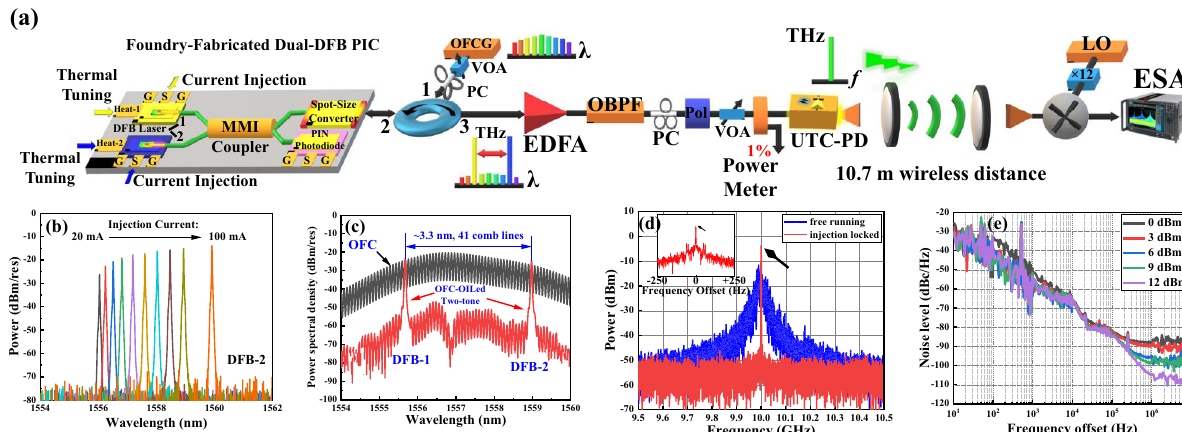
Fig. 3 Experimental setup and results of high-purity THz carriers generation. a A master-slave optical injection-locking-based THz carrier generation scheme. The two DFB lasers are injection-locked as slaves by the master OFCG. The polarization state and injection strength are controlled and optimized by a polzarization controller (PC) and a variable optical attenuator (VOA), respectively. The output OFCG-locked two-tone signal passes through the port 3 of the circulator. The wavelength of each DFB tone is tuned by the thermal tuning current of the integrated heater, and the intensity is controlled with the injection current. The two-tone signal with separation of 408 GHz is then ampli fi ed, band-pass fi ltered, and polarization-aligned before being photomixed at the UTC-PD, generating a 408-GHz signal with broadband modulation. The signal is propagated over 10.7-meter distance before being detected and down-converted by a Schottky Barrier Diode (SBD)-based subharmonic mixer. An electrical spectrum analyzer (ESA) is used t monitor the down-converted intermediate frequency (IF) signal. b The optical spectra of the DFB-2 laser wavelength shifted between 1556 nm and 1560 nm, driven by injection current changing between 20 mA and 100 mA. The laser intensity varies accordingly. c The optical spectra of the two lasers and the OFC. The laser wavelengths are set to 1555.375nm and 1558.975 nm with 3.3 nm (408 GHz) separation, spanning over 41 comb lines of 9.951 GHz comb-spacing from the MLL-based OFC. d The electrical spectra of the IF signal with and without the injection locking. The IF signal drifts around 10 GHz when free-running, shown as the blue trace. After being injection-locked to the OFC, the linewidth of the IF signal is much narrower and the power is 10 dB higher than the free-running case, shown as the red trace. e The single-sideband (SSB) phase noise as a function of comb-injection powers. The SSB phase noise decreases at higher injection power, particularly observable from the phase noise fl oors at >100 kHz frequency